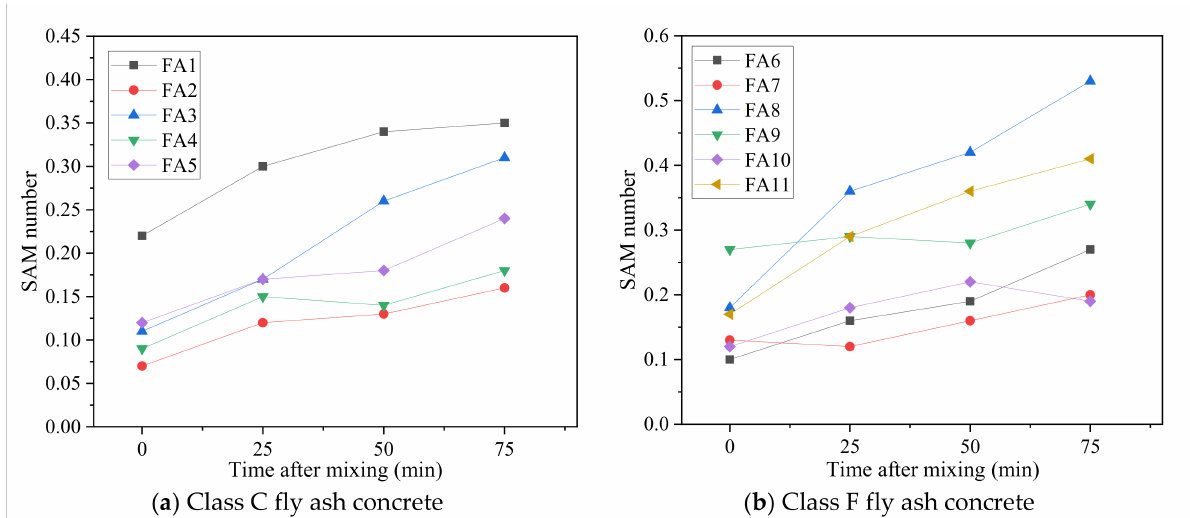
Figure 7. Variation in SAM number of fresh concrete over time ( a ) Class C fly ash concrete ( b ) Class F fly ash